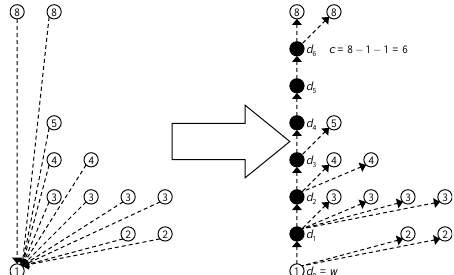
Figure 5. Example of the construction of the zero-edge tree from a ZDD by inserting dummy nodes and adding/deleting edges. A black and white circle represents a dummy and real node, respectively. The number in a circle represents its index. A dotted arrow in the left figure represents a